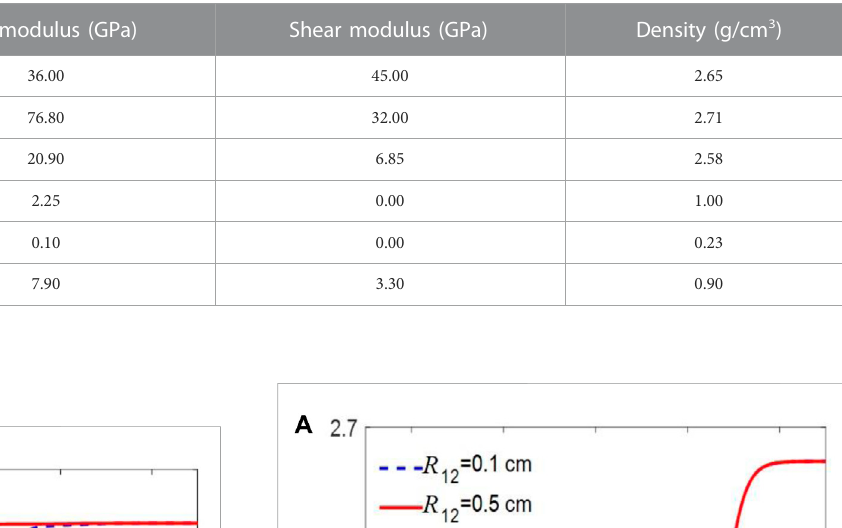
TABLE 1 Properties of the phases (Helgerud et al., 1999).